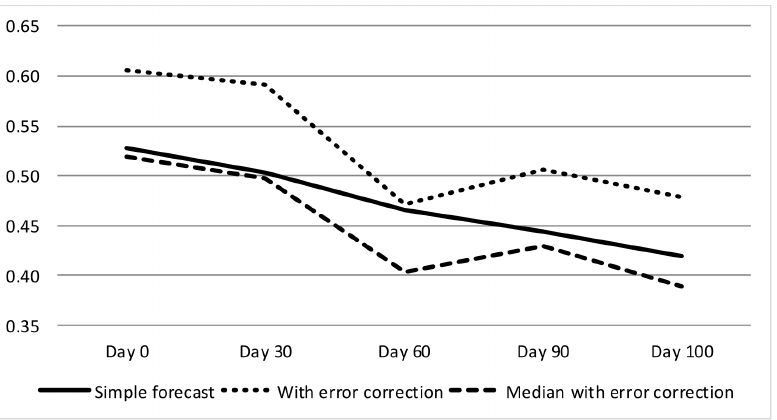
Figure 1. Mean absolute out-of-sample forecast error of Model 1 with and without last-error cor- rection and progressively updated with more data over the current quarter (percentage points,